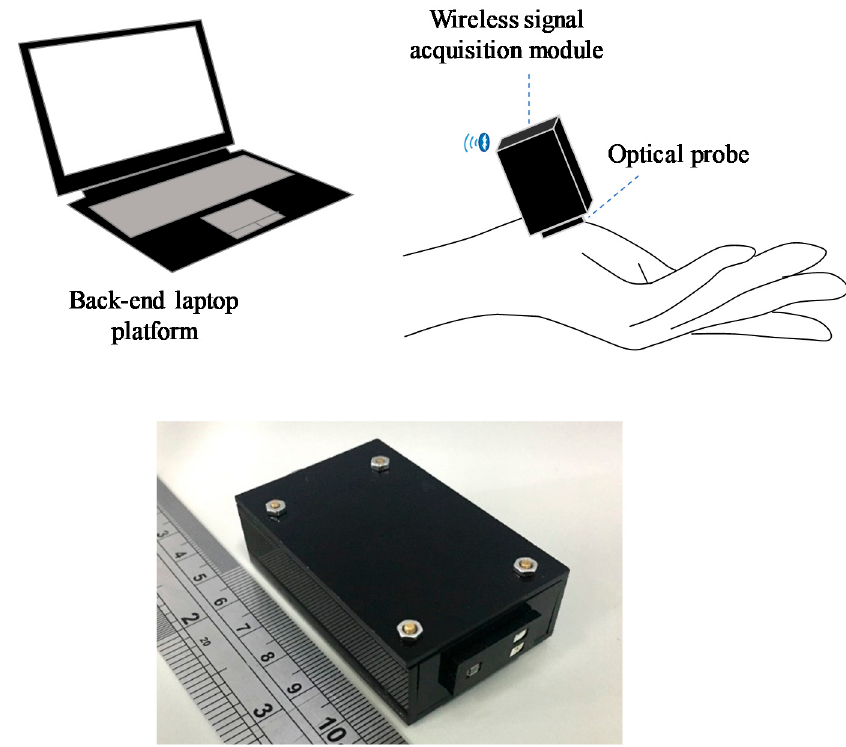
Figure 1. Basic scheme of optical device.